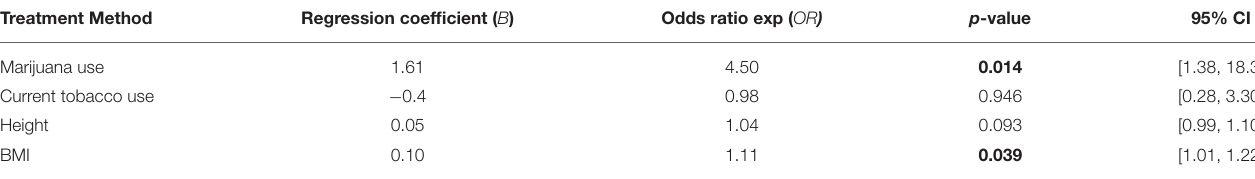
TABLE 3 | Logistic regression model for PSP